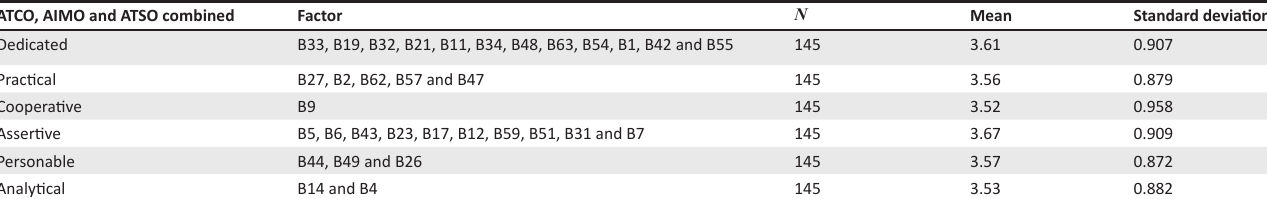
TABLE 2: Noteworthy leader trait factors and items (noted as